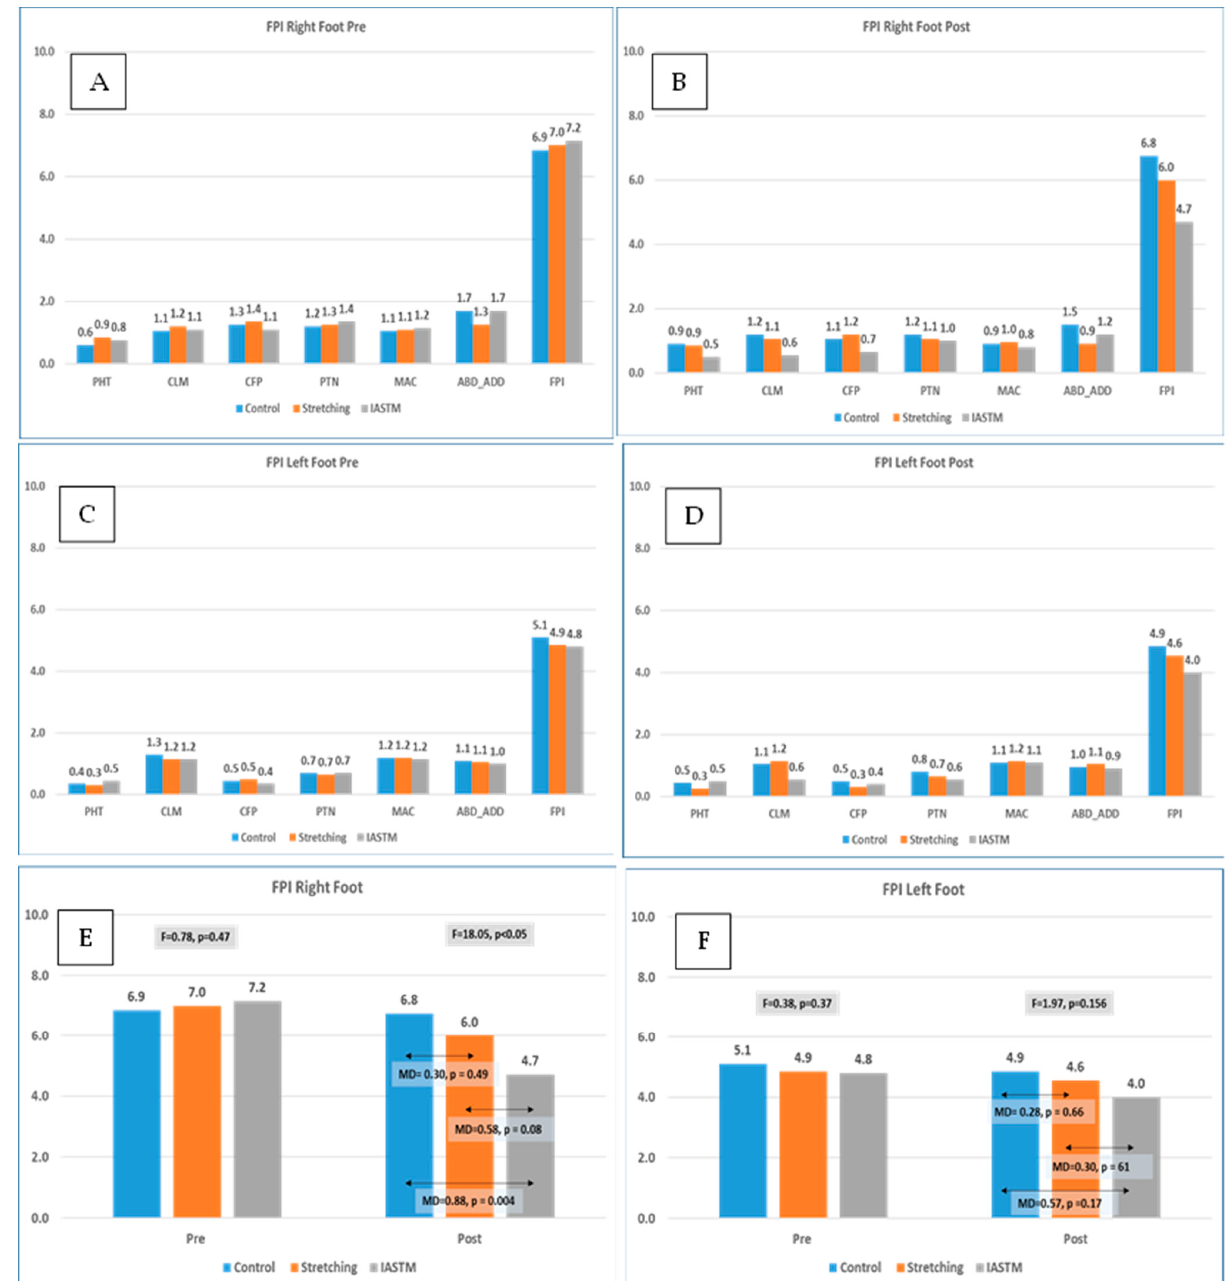
Figure 2. Pre and post assessment of the foot posture index-6 sub-scores and total scores in right and left foot between the control, stretching, and IASTM groups. ( A ) represents the pre assessment of FPI-6 sub-scores and total FPI of right foot; ( B ) represents post assessment of FPI-6 sub-scores and total FPI of right foot; ( C ) represents the pre assessment of FPI-6 sub-scores and total FPI of left foot; ( D ) represents post assessment of FPI-6 sub-scores and total FPI of left foot; ( E ) represents comparison of pre and post measurement of FPI of right foot between control, stretching, and IASTM; and ( F ) represents comparison of pre and post measurement of FPI of left foot between control, stretching, and IASTM. Note: PHT, palpation of the head of the talus; CLM, curvatures above and below the lateral malleolus; CFP, position of the calcaneus in the frontal plane; PTN, prominence in the talonavicular joint; MAC, medial longitudinal arch’s congruence; ABD/ADD, abduction/adduction of the forefoot on the rearfoot; MD, mean difference.